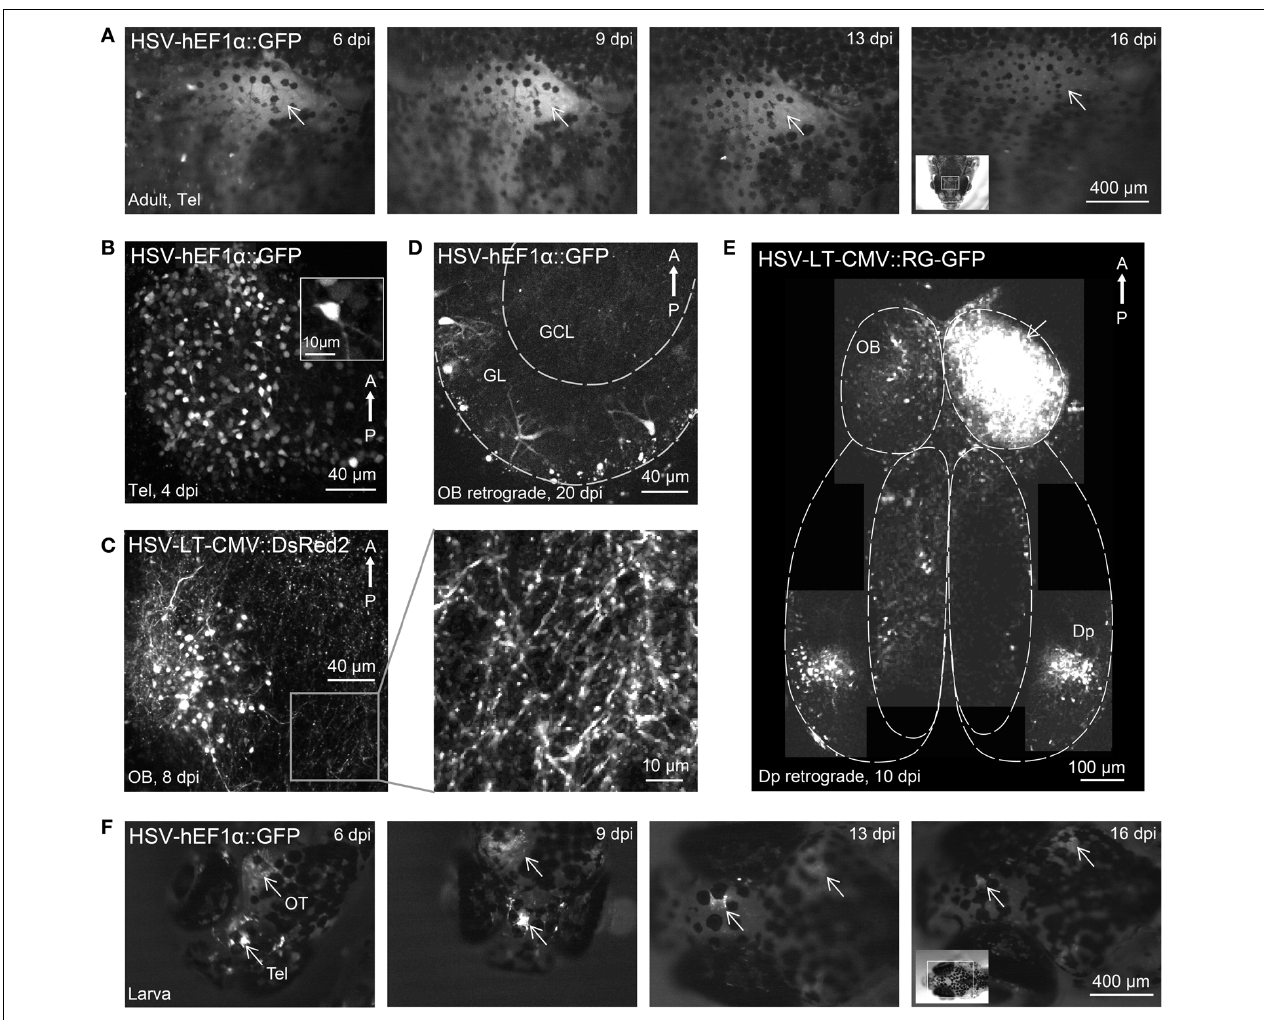
FIGURE 2 | Gene expression in the zebrafish brain using HSV-1. (A) Fluorescence images of the dorsal head of an adult zebrafish at different time points after injection of HSV-1 (#1). Images were taken with a fluorescence stereomicroscope; arrow indicates region of strong fluorescence. (B) Telencephalic neurons expressing GFP 4 days after injection of HSV-1 into the dorsal telencephalon (#1; z -projection of multiphoton stack). (C) Olfactory bulb neurons expressing DsRed2 8 days after injection of HSV-1 into the olfactory bulb (#7; z -projection of multiphoton stack). Boxed region is shown at higher magnification on the right. (D) Transgene expression in olfactory